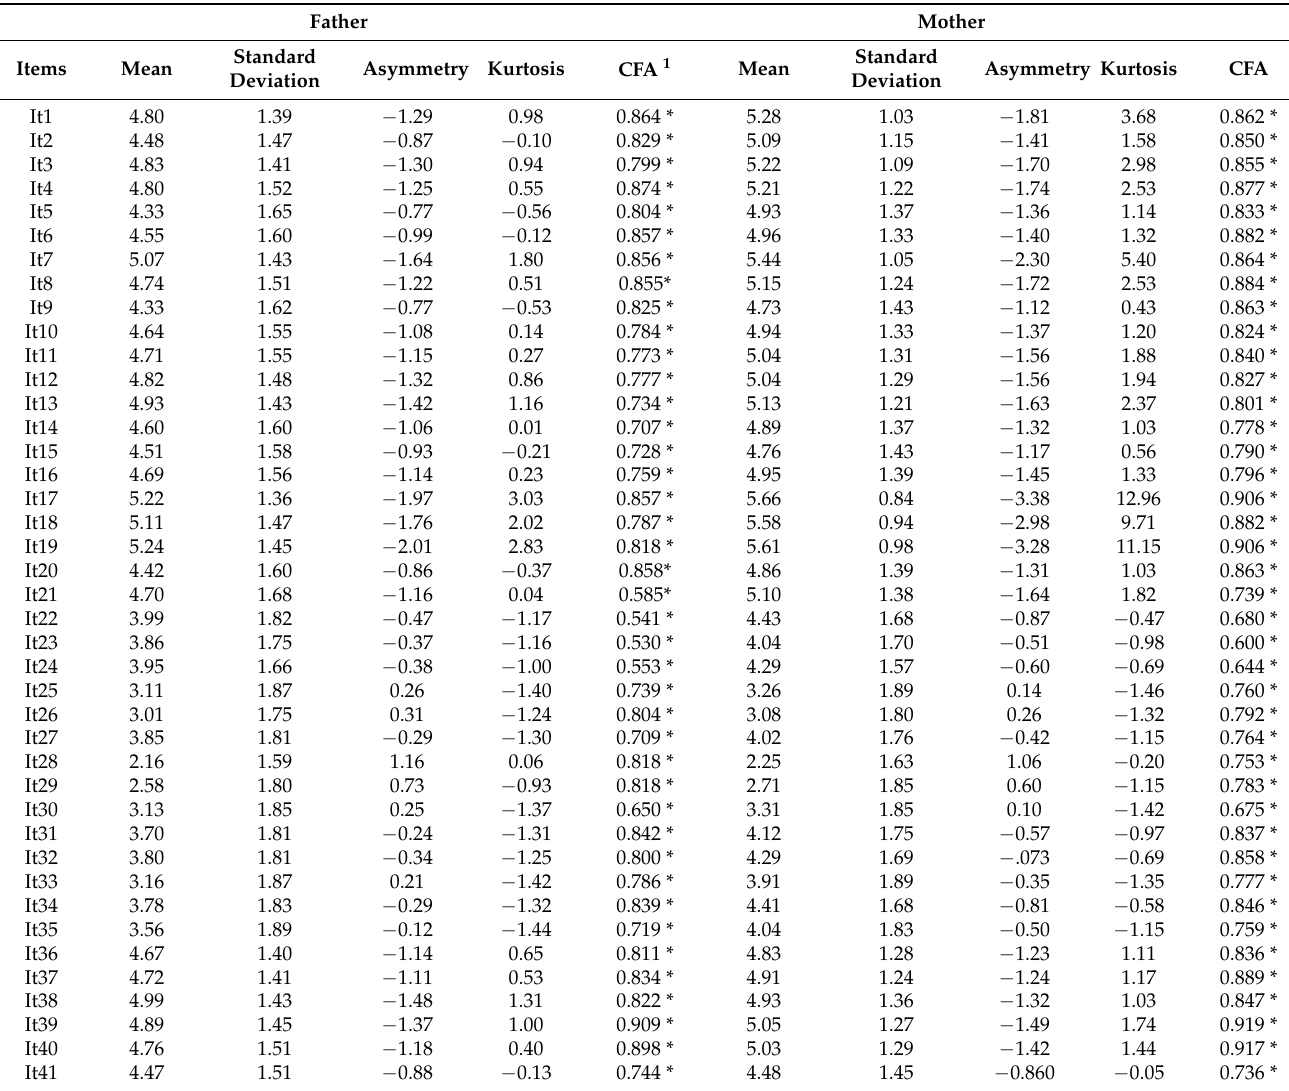
Table 1. Descriptive statistics and confirmatory factor